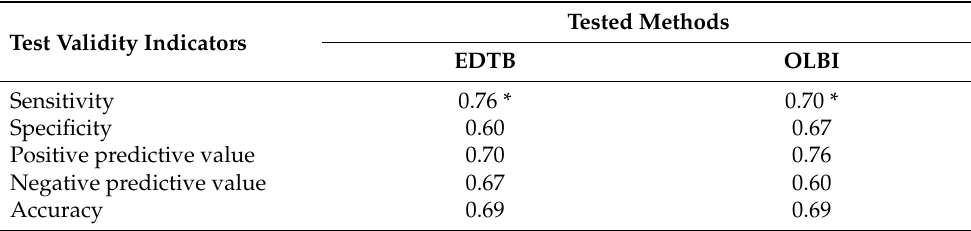
Table 6. Comparison between test validity indicators of the EDTB and the